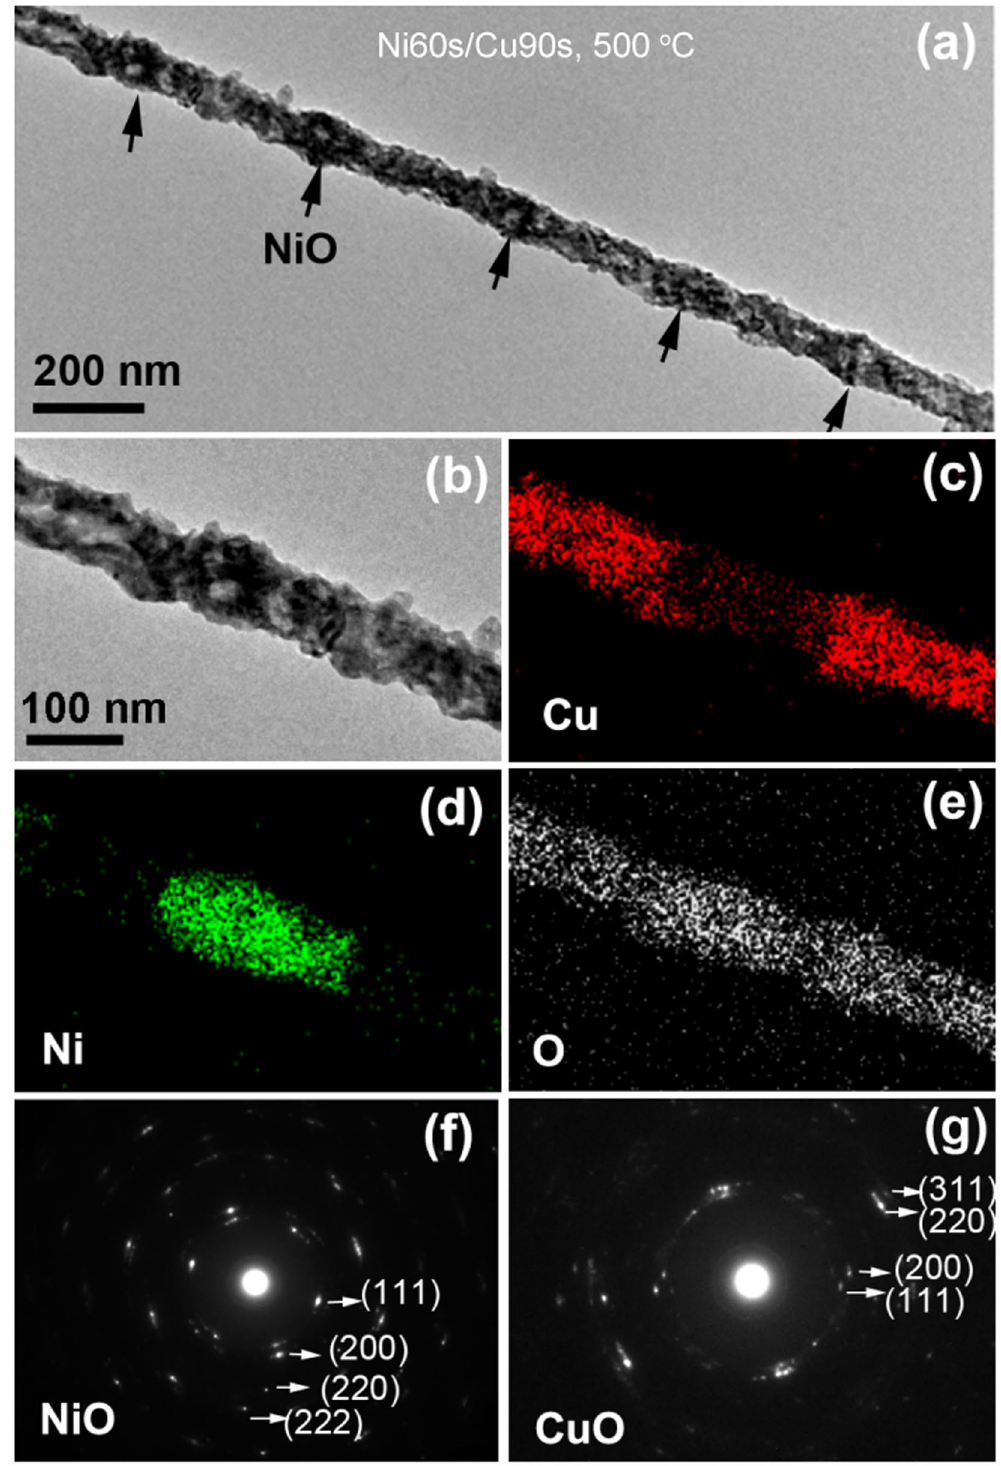
Figure 9. The Ni60s/Cu90s sample after annealing at 500 °C for 2 h. ( a ) TEM image of the annealed single nanowire; ( b – e ) the magnified TEM image and the corresponding EDS elements mapping images; ( f ) SAED pattern of the NiO segment; ( e ) SAED pattern of the CuO